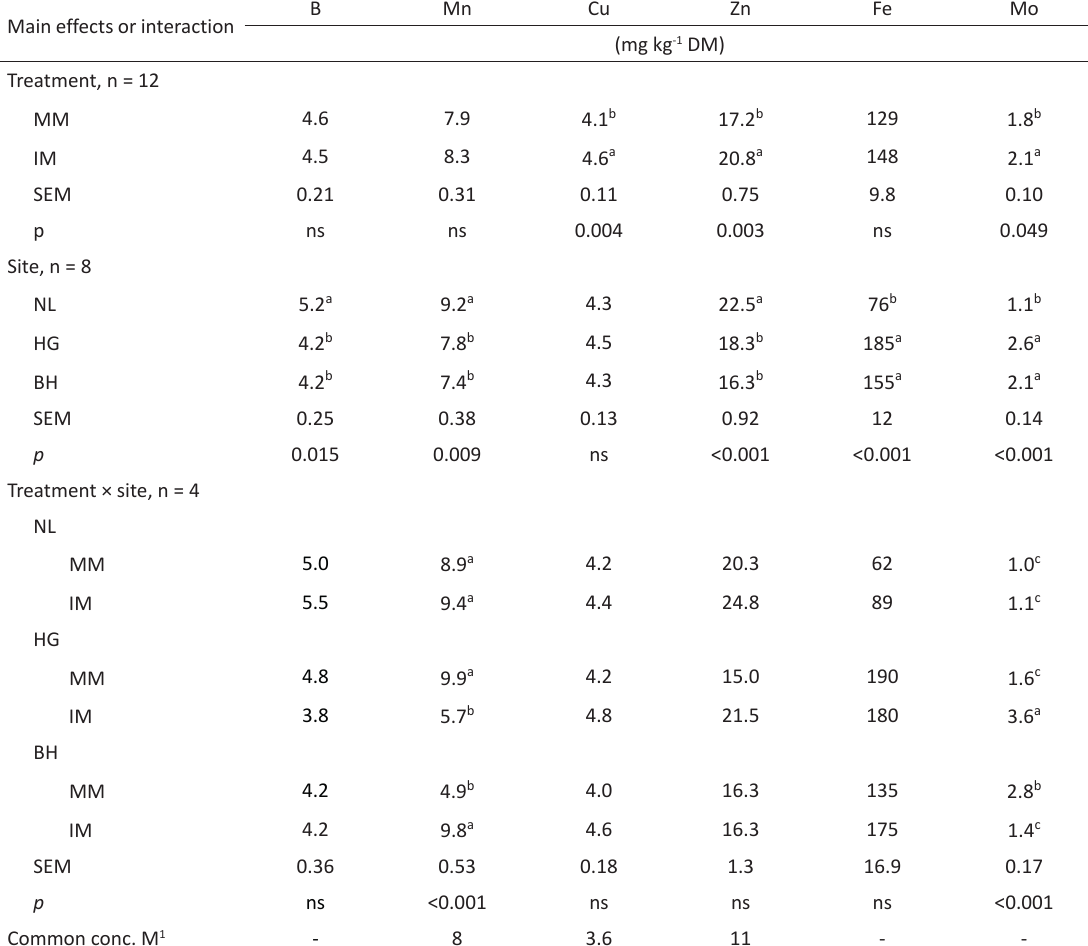
Table 5. Concentrations of micro nutrients in intercropped and monocropped maize in three field experiments Main effects or interaction